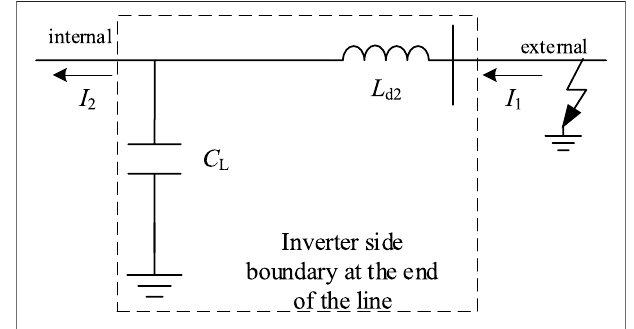
FIGURE 4 | Inverter-side boundary at the end of the